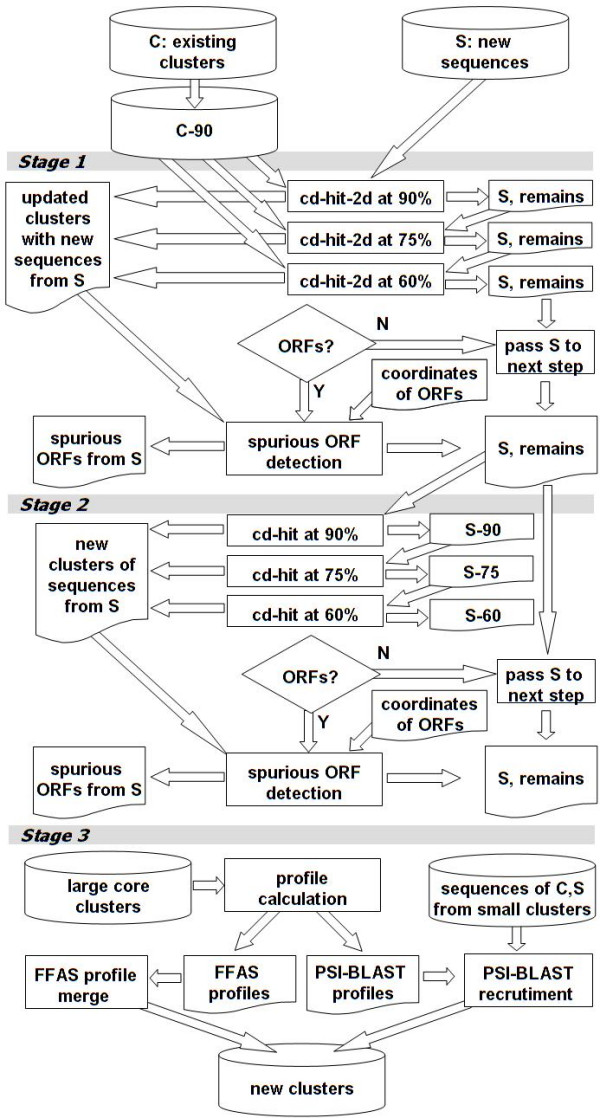
Flow chart of the incremental clustering method.